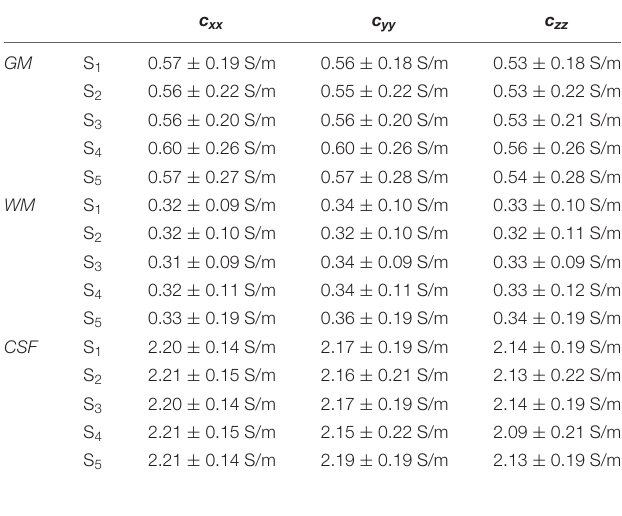
in all subjects at LF (left) and HF GM ,φ WM )